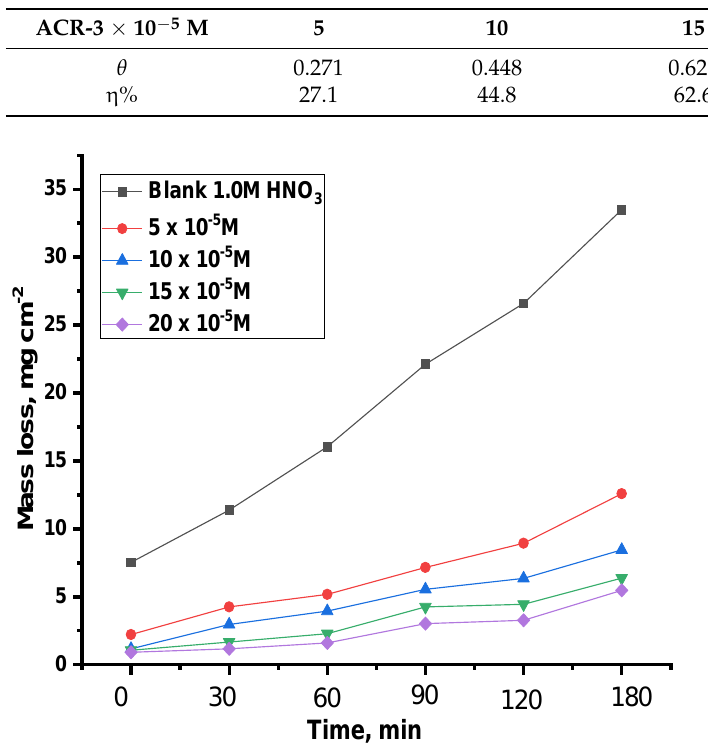
Table 3. Different measurements of inhibition for the corrosive effects of 1.0 M HNO 3 on copper with different concentrations both with and without ACR-3 at 25 ◦ C.